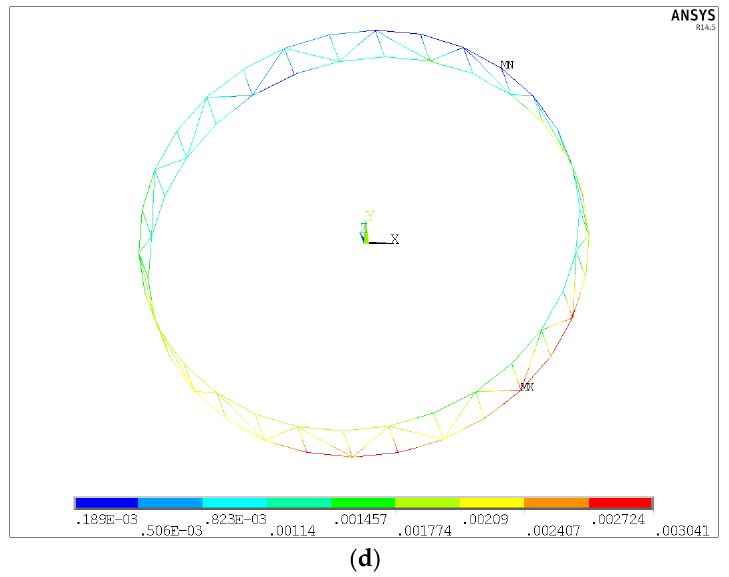
Figure 11. The contour nodal displacement solution of the supporting truss: ( a ) the initial iteration, ( b ) the first iteration, ( c ) the second iteration, and ( d ) the third iteration.